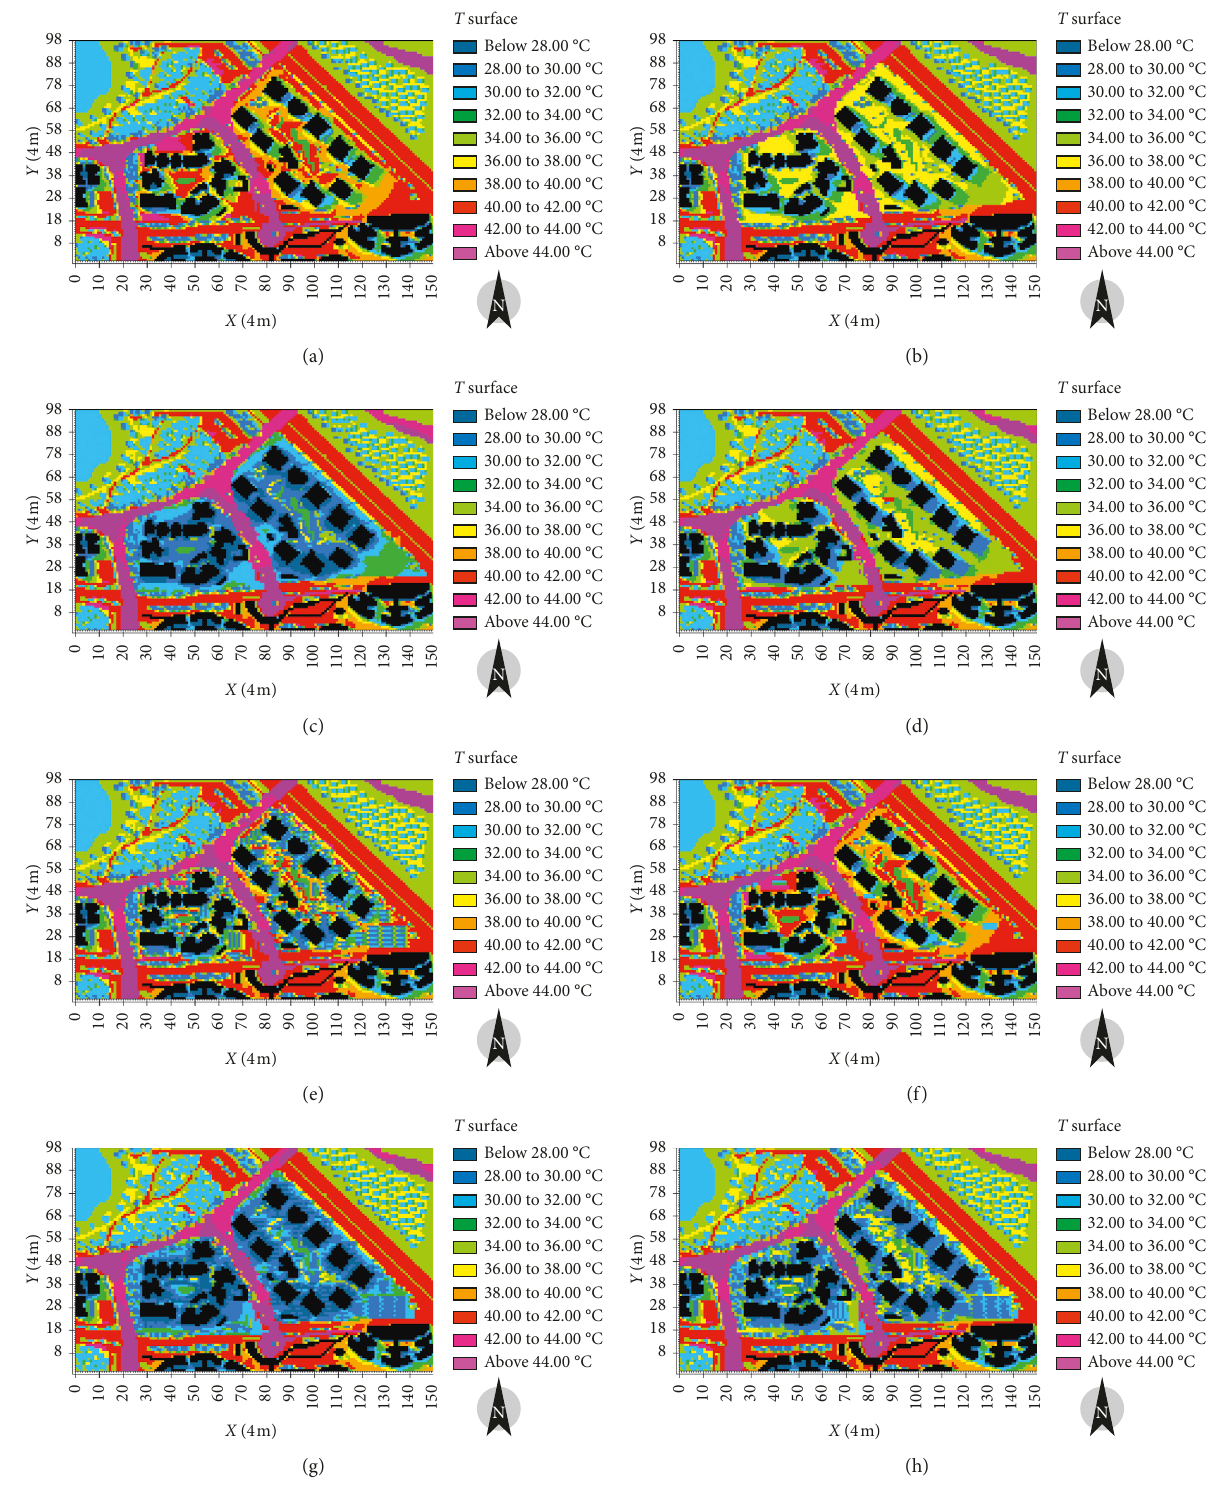
Figure 6: Simulated surface temperature for all design scenarios. (a) Base case. (b) Scenario 1 (wooden boards). (c) Scenario 2 (light-color granite). (d) Scenario 3 (grass surface). (e) Scenario 4 (more trees). (f) Scenario 5 (more water bodies). (g) Scenario 6 (light-color granite +more trees). (h) Scenario 7 (grass surface+more